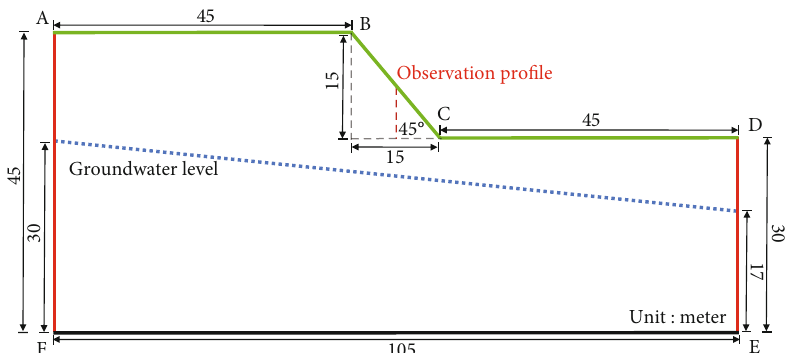
Figure 1: Conception of the slope model.